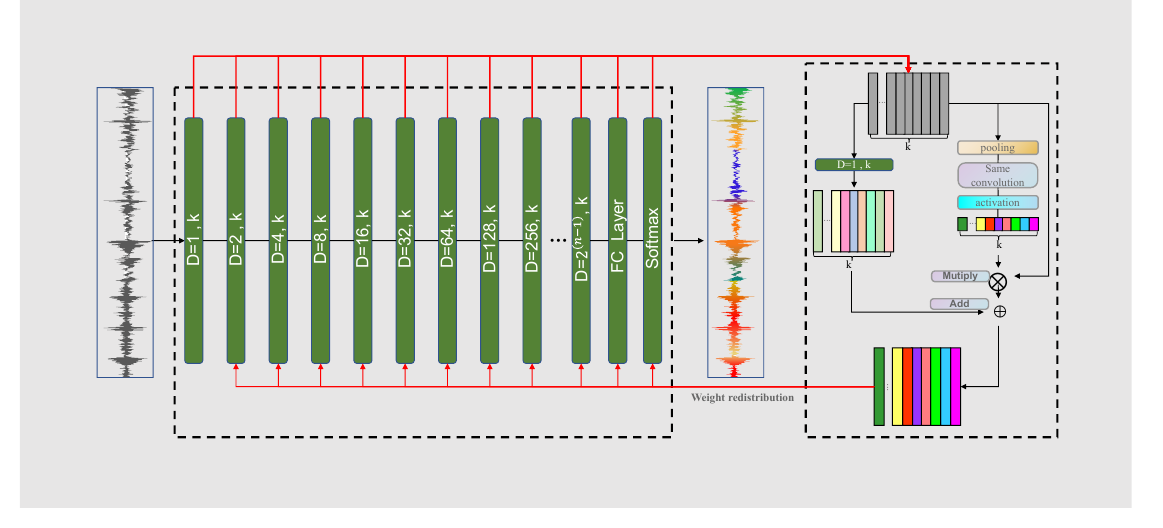
Figure 2. ECNN model of structures.